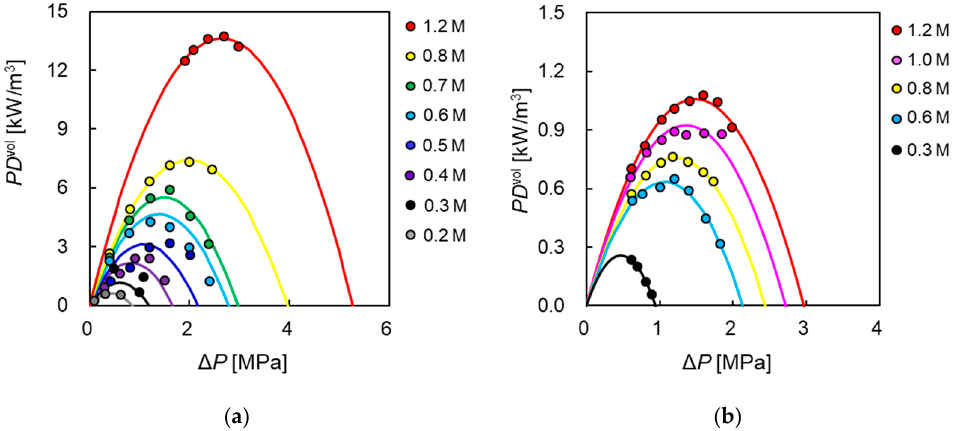
Figure 11. Volumetric gross power density, PD vol , as a function of applied hydraulic pressure difference, Δ P, membrane module: ( a ) PA-SW and ( b ) CTA-HF with FS: treated tap water. Q DS : 10.0 L/min . Q FS : 5.0 L/min.